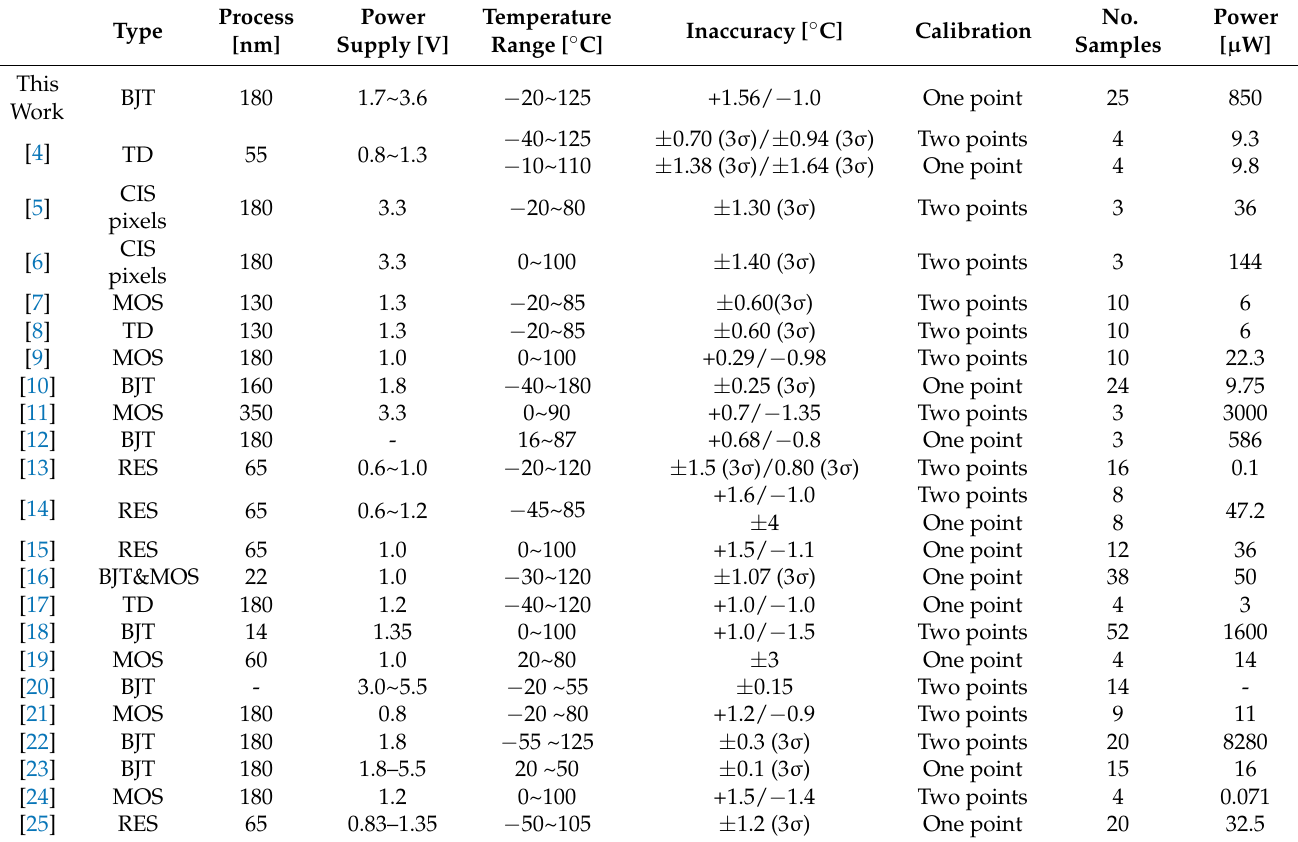
Table 2. Comparison with recently reported digital temperature